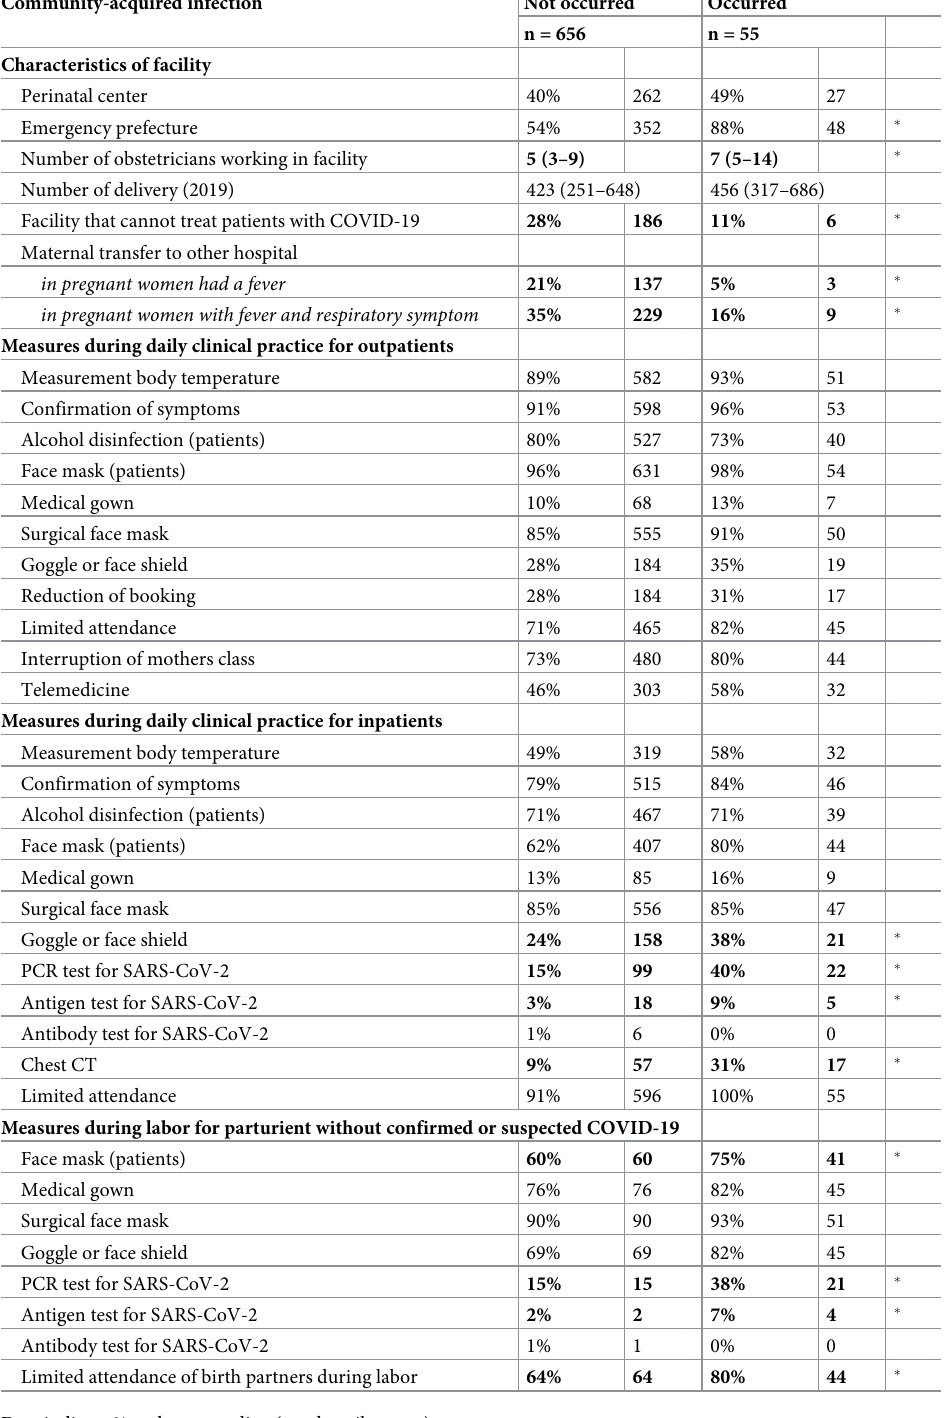
Table 2. Characteristics and preventive measures in hospitals where community-acquired infection occurred and not occurred in Japan. Community-acquired